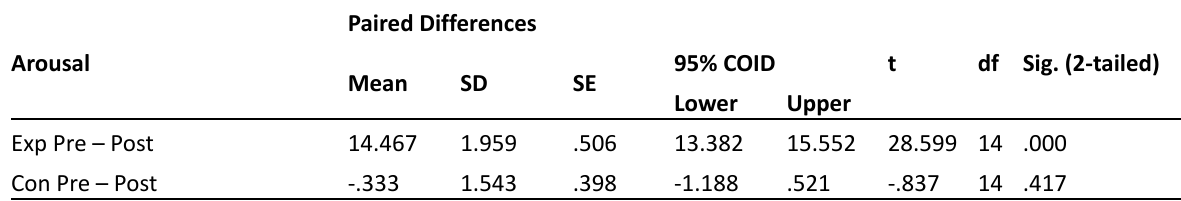
Table 7. Pre and post mean differences of experimental and control groups for arousal Paired Arousal